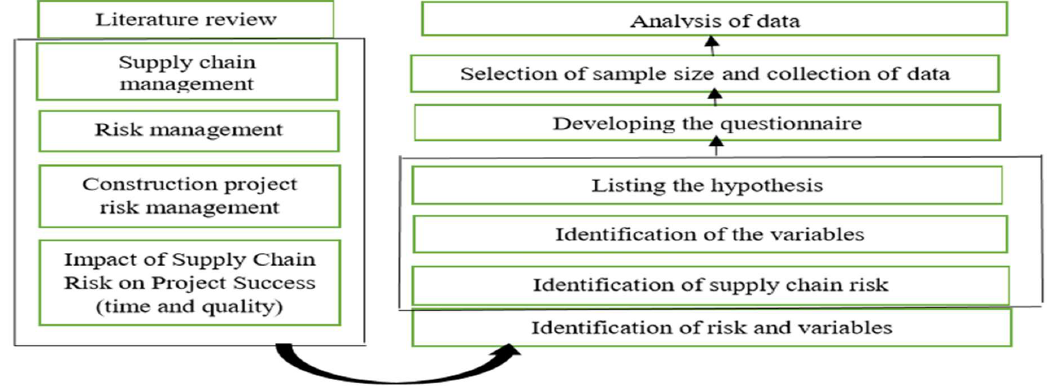
Fig. 2. Map of research process/framework of this